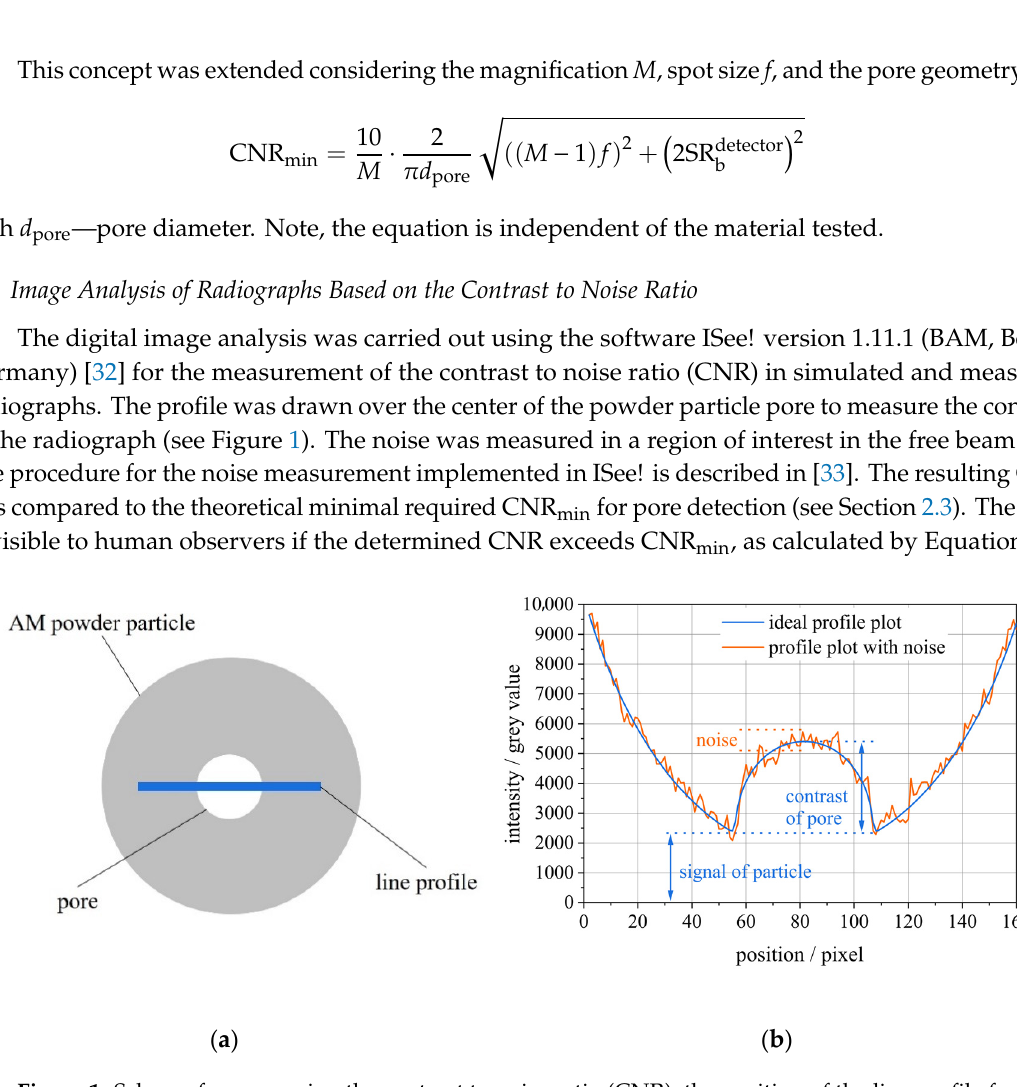
Figure 2. Schematic representation of the radiographic setup with source, object, and detector in ( a ), and the 130 kV spectrum plot used in the simulation in ( b ).